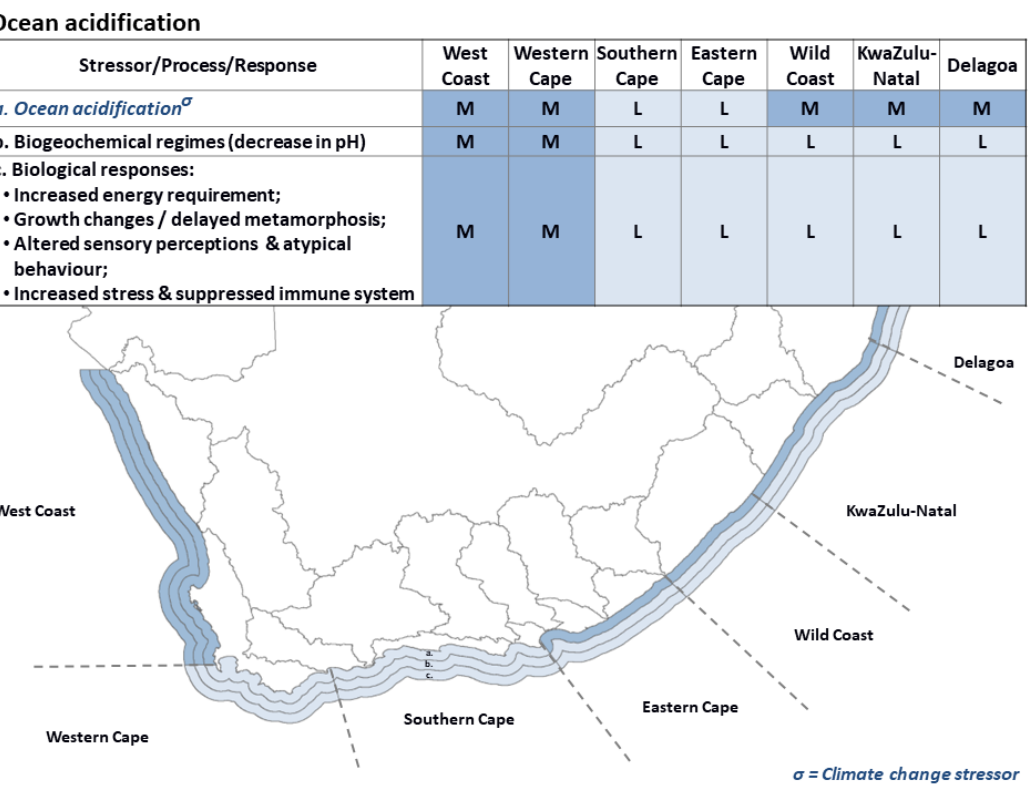
Figure 6. Summary of vulnerability ranking (high/medium/low) for estuaries in seven regions associated with ocean acidification (colour zones on map depict ( a ) to ( c ) in table moving outward from the coast with H = high, M = medium, L = low).